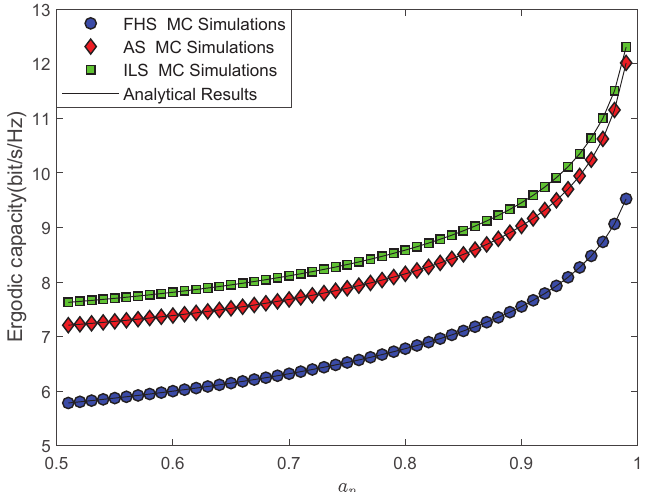
Figure 2. The EC versus a p for different SR fading